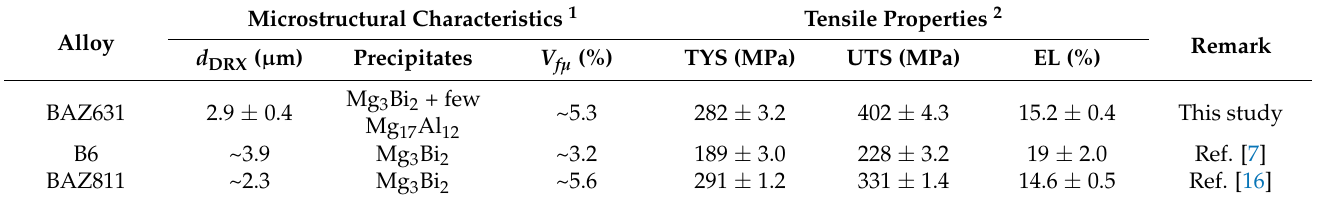
Table 1. Microstructural characteristics and tensile properties of extruded BAZ631 alloy, compared with B6 and BAZ811.